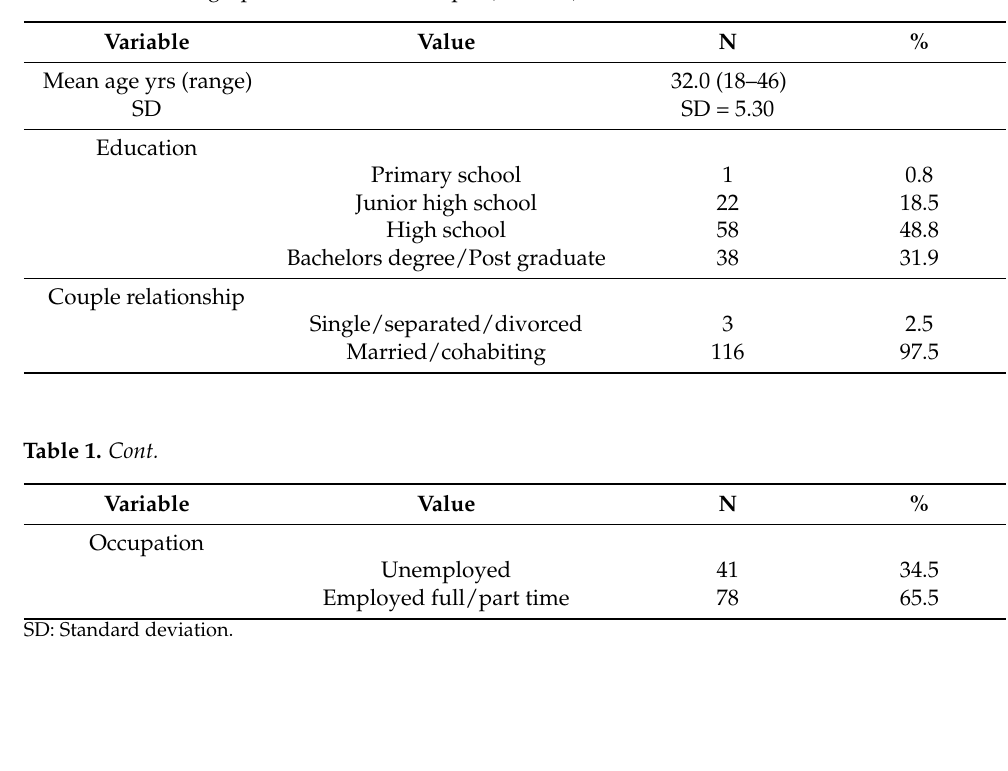
Table 1. The demographics of the total sample (N = 119).